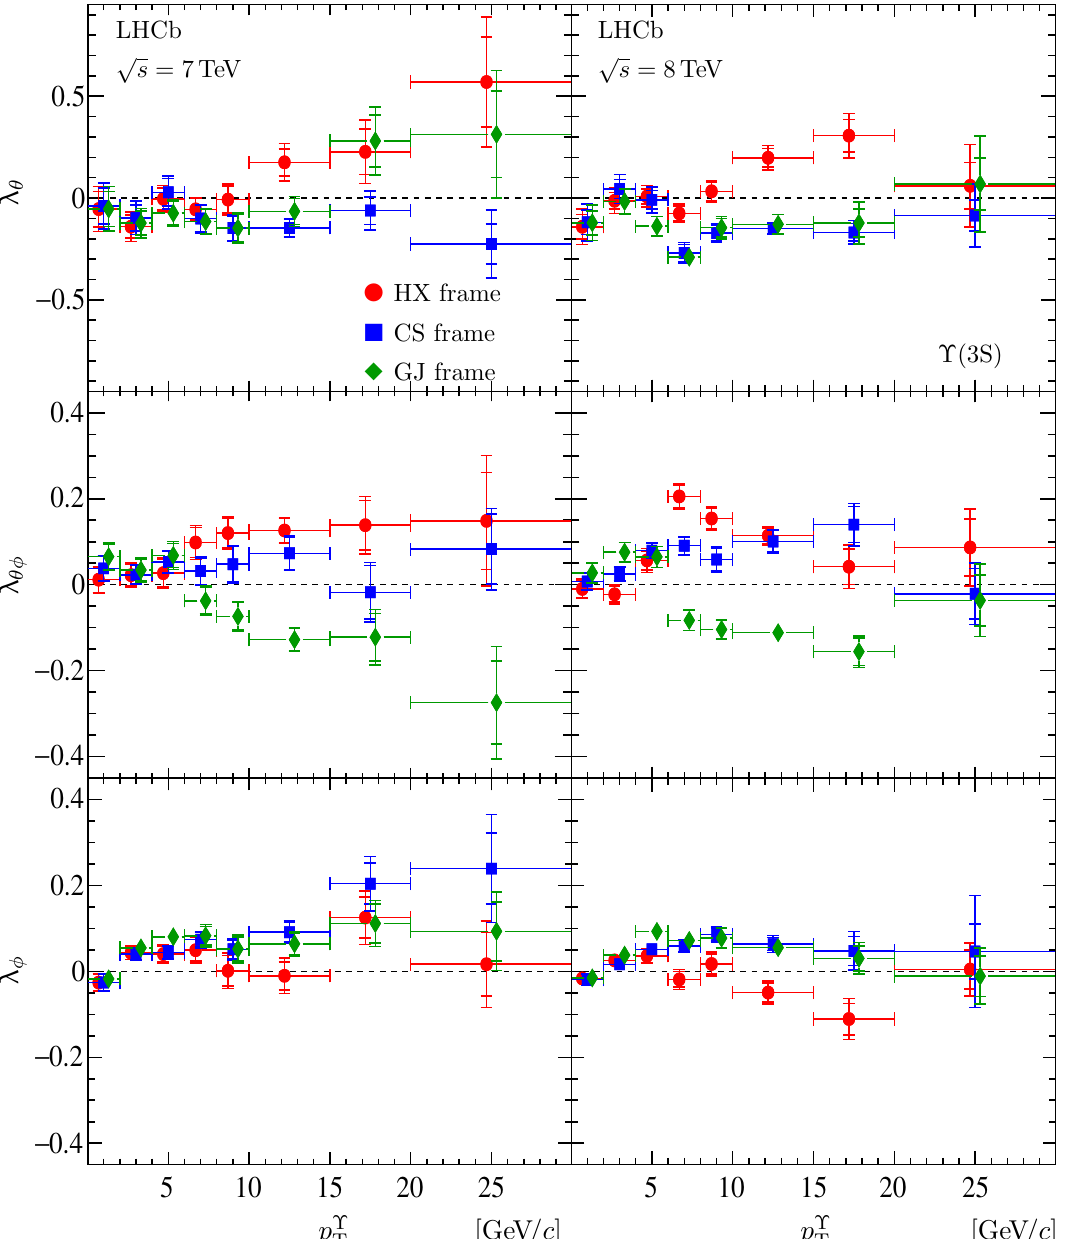
Figure 14 . The polarization parameters (top) (cid:21) (cid:18) , (middle) (cid:21) (cid:18)(cid:30) and (bottom) (cid:21) (cid:30) , for (cid:7)(3S) mesons as a function of p (cid:7) , for the rapidity range 2 : 2 < y (cid:7) < 4 : 5, for data collected at (left) T p and (right) s = 8 TeV. The results for the HX, CS and GJ frames are shown with red circles, blue squares and green diamonds, respectively. The inner error bars indicate the statistical uncertainty, whilst the outer error bars indicate the sum of the statistical and systematic uncertainties added in quadrature. Some data points are displaced from the bin centers to improve visibility.